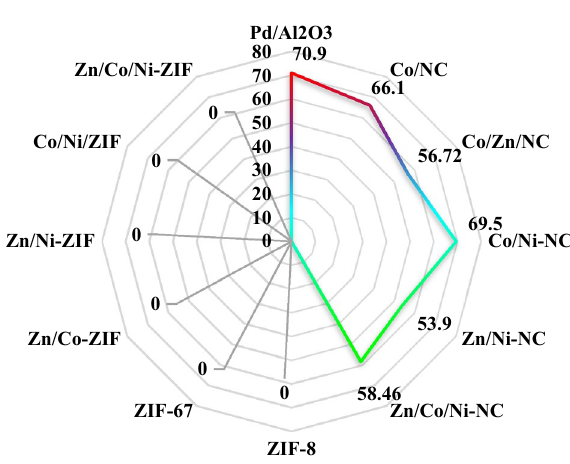
Figure 9. Conversion of total olefins in the hydrogenation reaction.